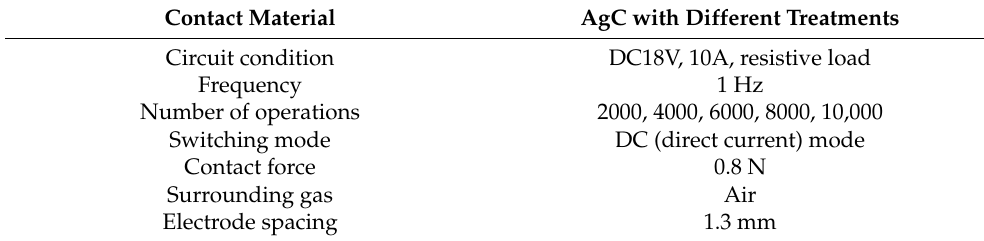
Figure 3. Schematic diagram of arc erosion tests. Table 1. Experimental parameters for arc erosion tests.